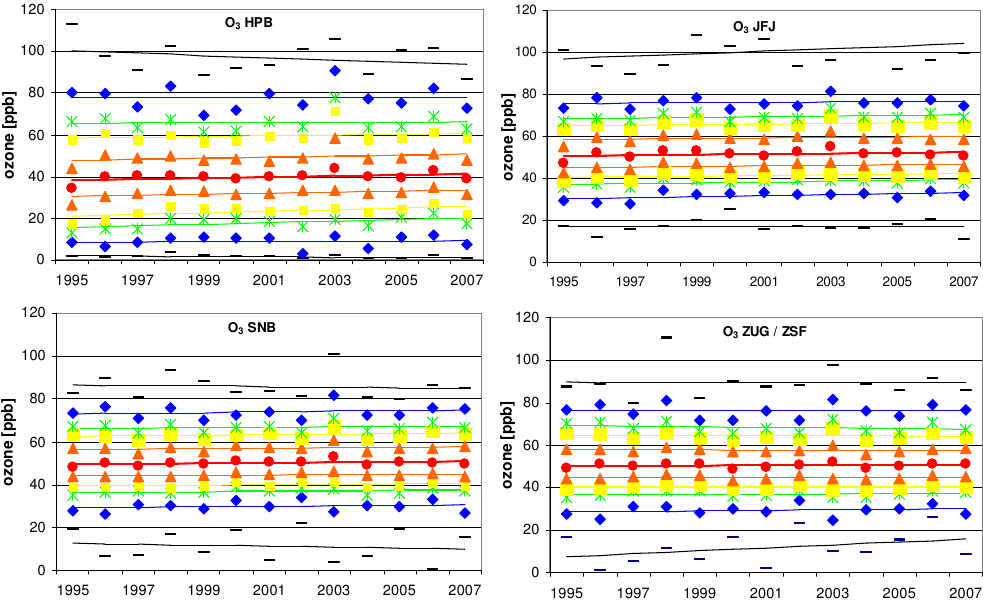
Fig. 4. O 3 time series of annual percentiles and respective linear trends at the “DACH” sites since 1995; black: minimum and maximum, blue: 1- /99- ; green: 5- /95- , yellow: 10- /90- ; orange: 25- /75-percentiles, red: median.